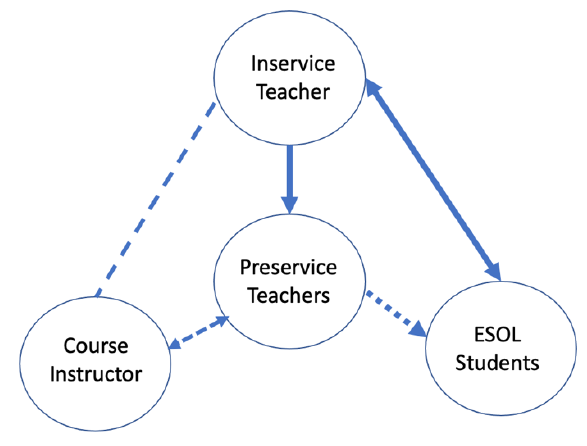
Figure 7. Implementation stage.